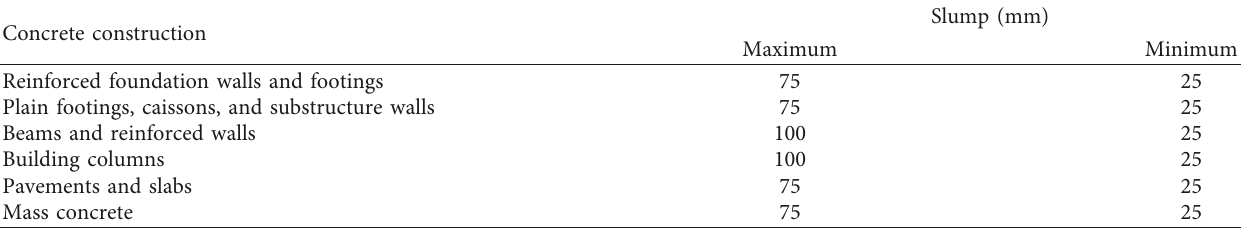
Table 7: Recommended slumps for various types of construction “Table 7 is reproduced from Kosmatka et al. [39] (under the creative commons attribution license/public domain).”